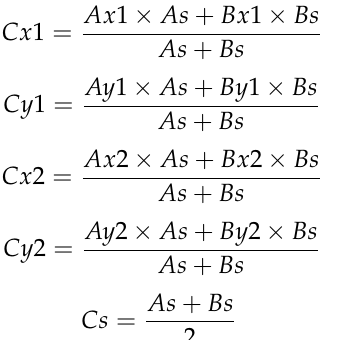
Figure 3. Process of two prediction boxes fusing into one box through the fusion box formula. The value calculated by Formulas (1) and (2) constitutes the upper-left coordinate of the bboxC fusion box; the value calculated by Formulas (3) and (4) constitutes the lower- right coordinate of the bboxC fusion box, and the confidence of the bboxC box is calculated by Formula